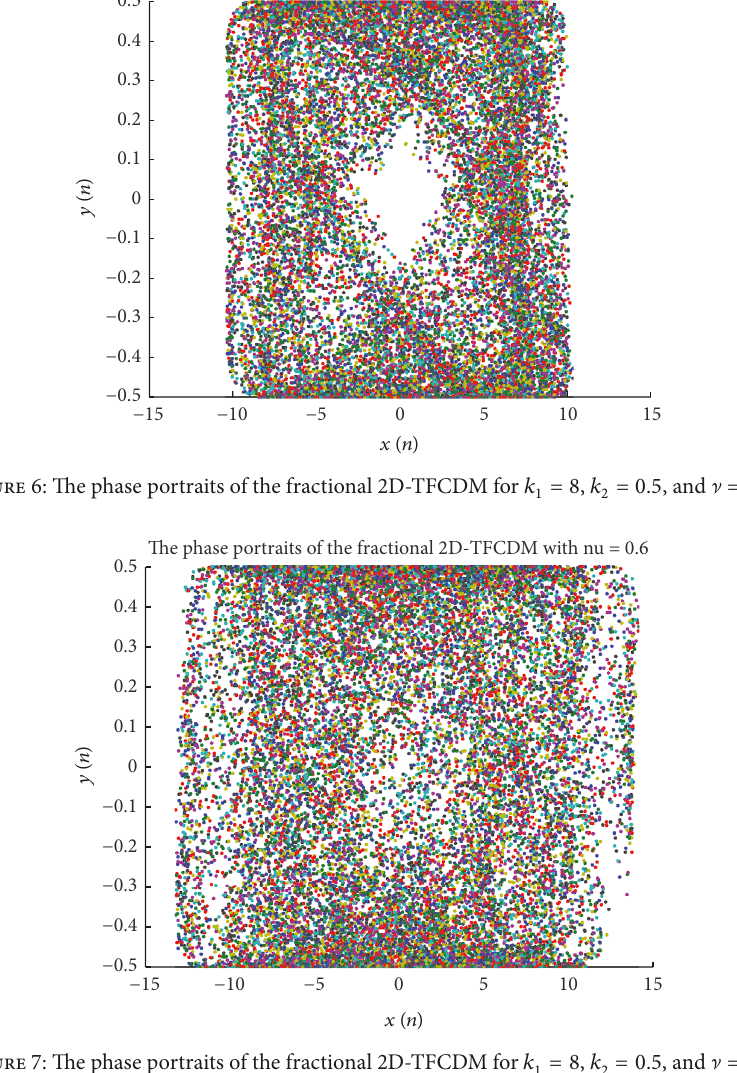
Figure 7: The phase portraits of the fractional 2D-TFCDM for 𝑘 1 = 8 , 𝑘 2 = 0.5 , and ] = 0.6 .